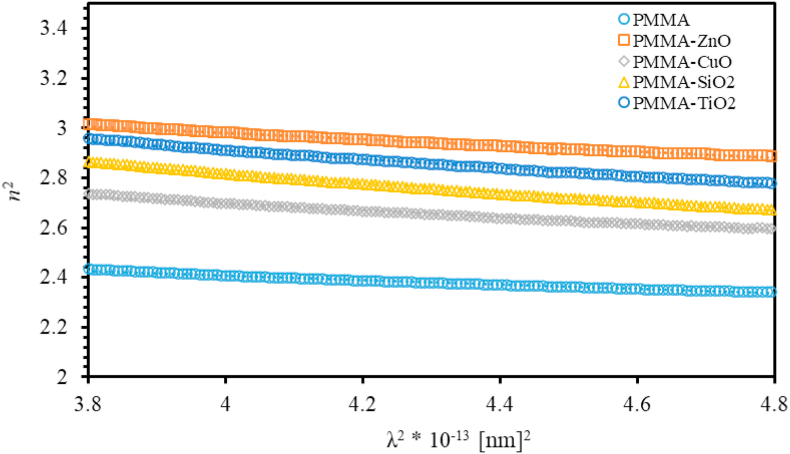
The variation of (n2=ε′) with λ2of PMMA and PMMA incorporated with ZnO, CuO, SiO2 and TiO2 NPs nanocomposites thin films.